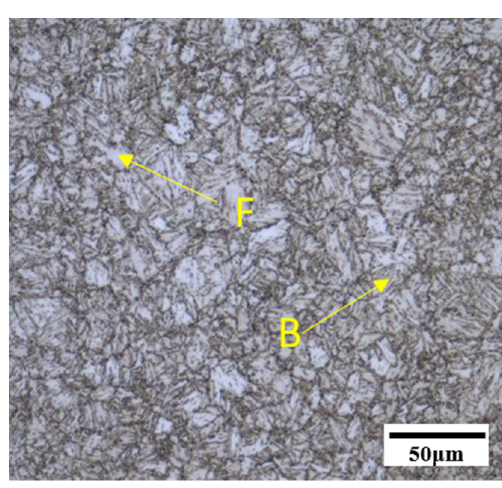
Figure 1. Microstructure of experimental steel.